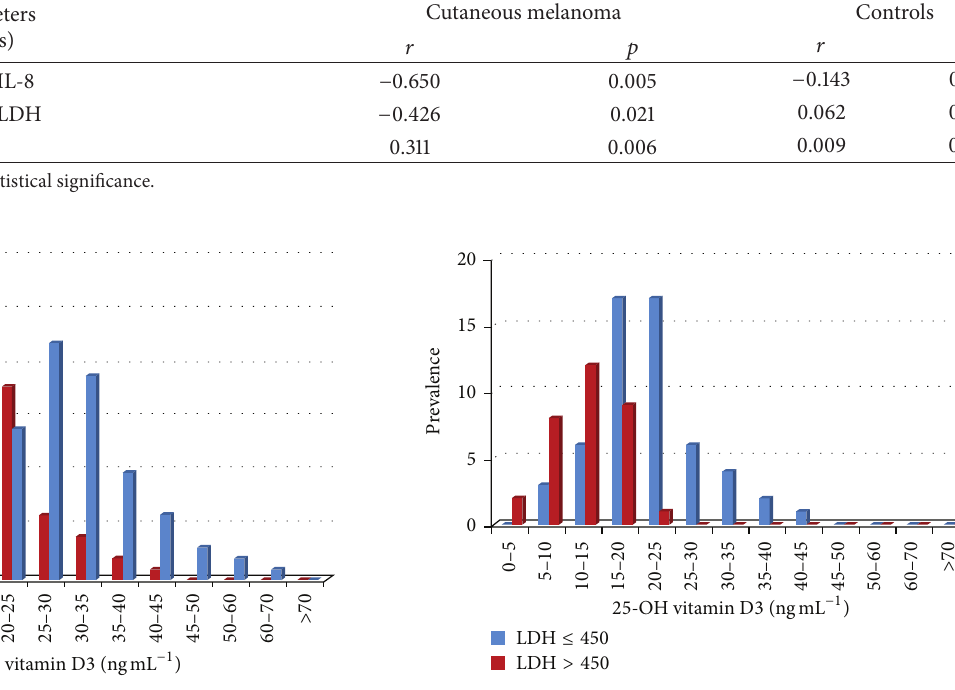
Figure 4: 25-OH vitamin D3 (ngmL −1 ) serum level in melanoma patients for individuals with normal and high LDH serum levels (U L −1 ). Prevalence depicts the subgroups of melanoma patients with high serum LDH congregating in the low serum 25-OH vitamin D3